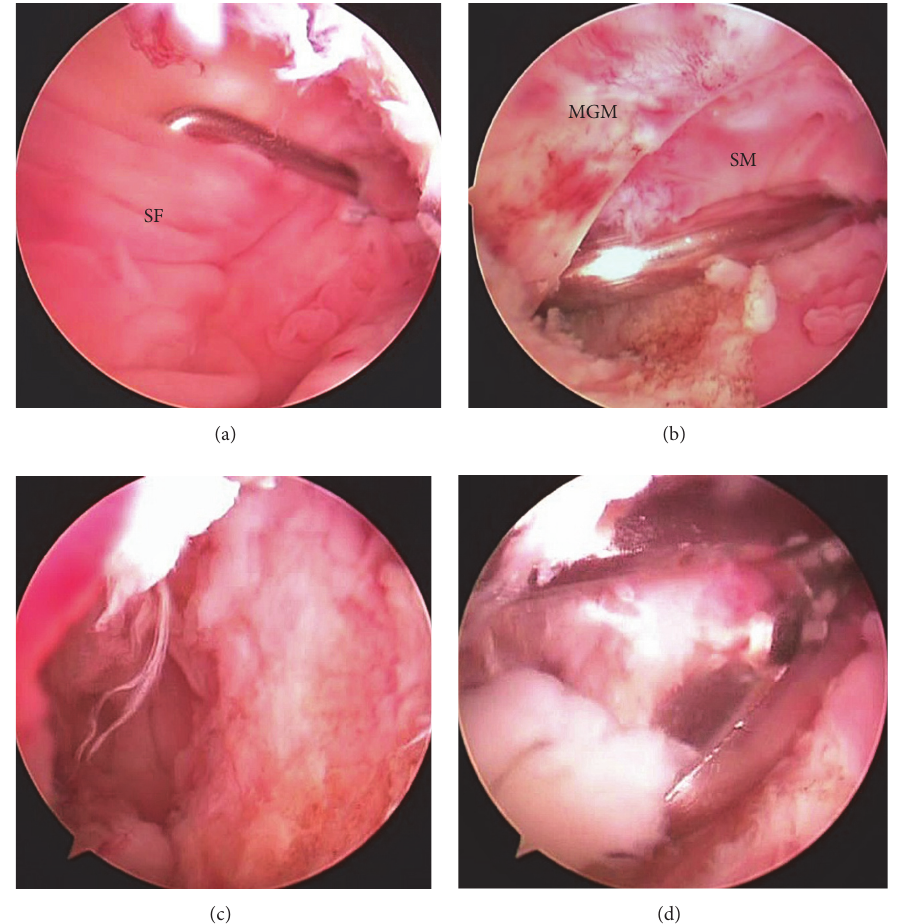
Figure 2: Arthroscopic views from the posterolateral portal through the transseptal portal. (a) The synovial fold (SF) was identified using a probe introduced from the posteromedial portal. (b) After removing the synovial fold, a switching rod was inserted between the medial head of the gastrocnemius muscle (MGM) and the semimembranosus muscle (SM), which was the orifice of the popliteal cyst. (c) The orifice of the popliteal cyst was enlarged by resecting the limited parts of the medial head of the gastrocnemius muscle and the semimembranosus muscle. (d) The material inside the cyst was pushed out from behind and removed using forceps.